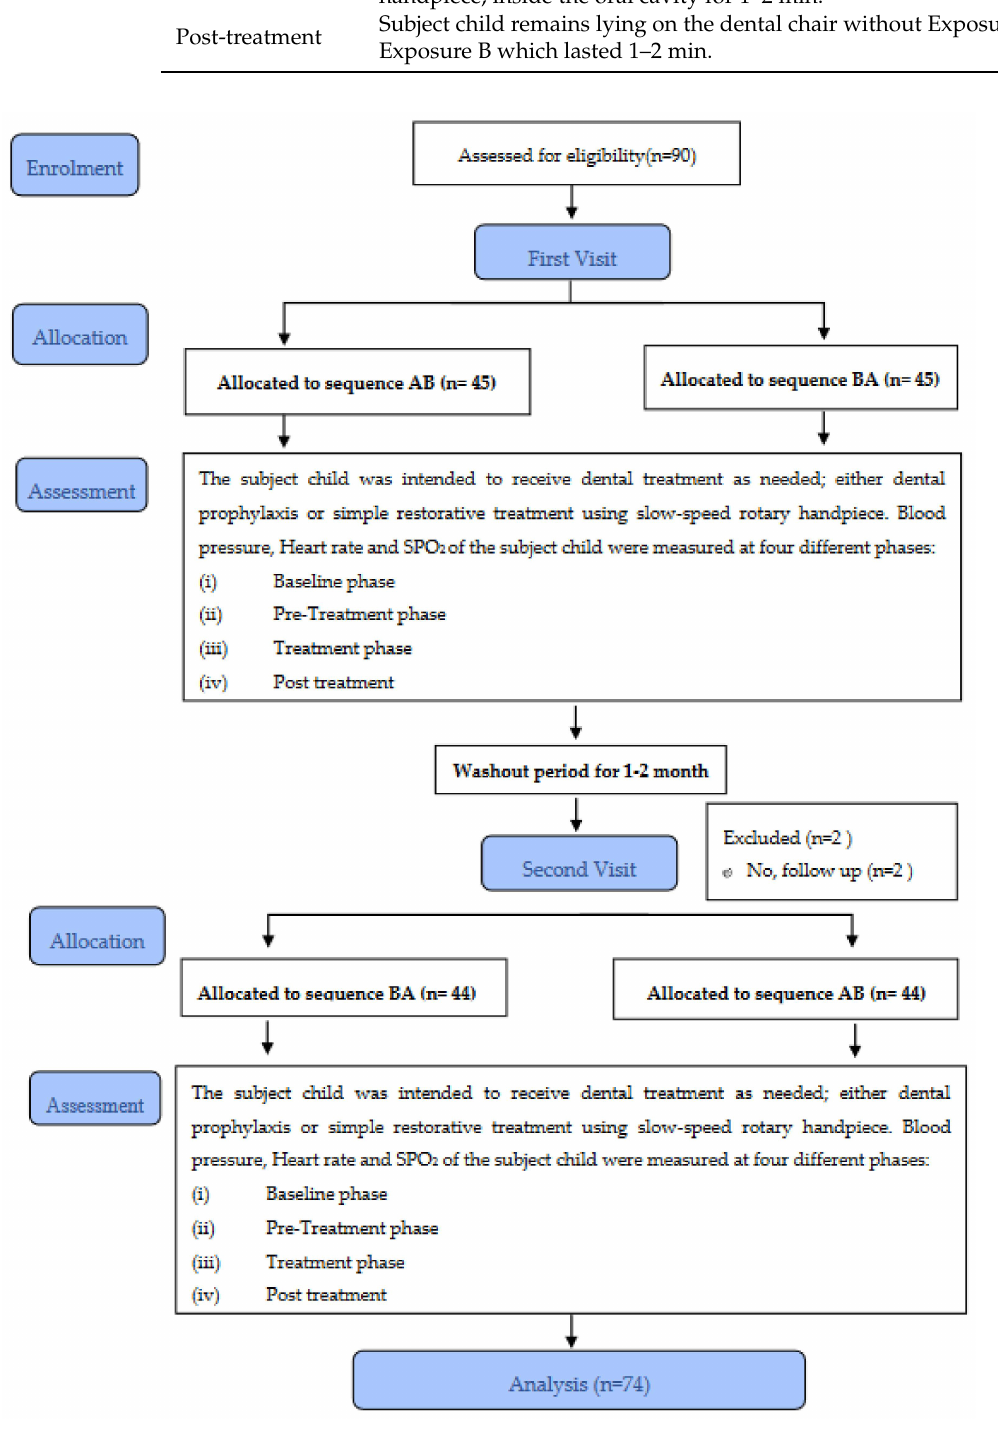
Figure 2. A CONSORT flow diagram for crossover